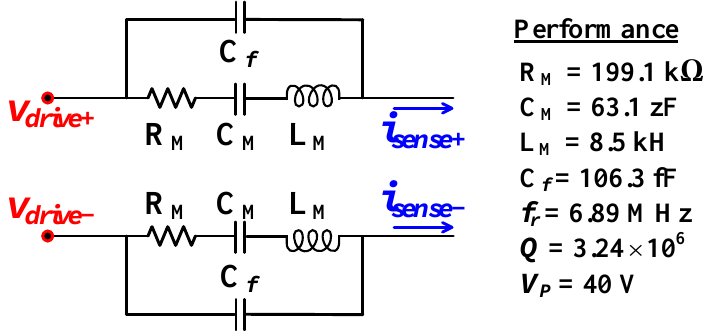
Figure 4. Extracted RLC equivalent model.